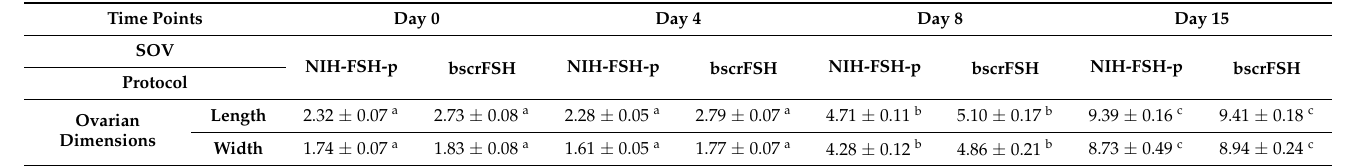
Table 2. Ovarian dimensional evaluation over time: NIH-FSH-p vs. bscrFSH SOV protocol.